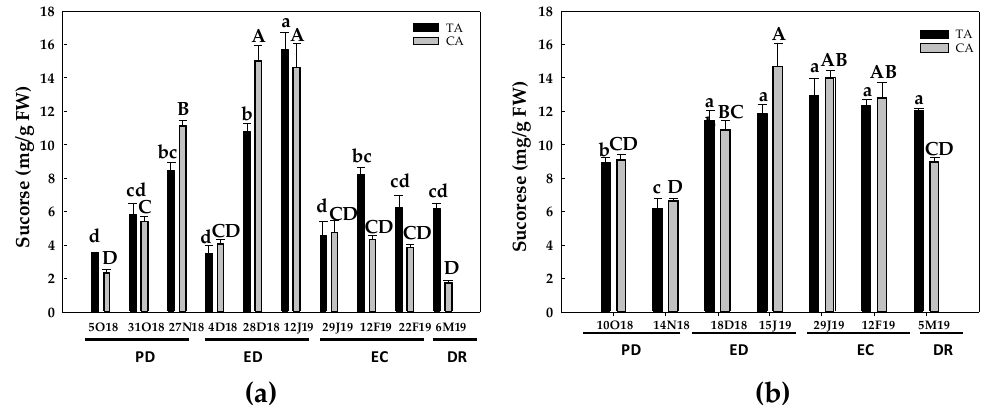
Figure 3. Evolution of sucrose contents in flower buds of peach ‘GEM020’ cultivated in two different geographical areas during the dormancy cycle on two seasons. ( a ): season 1 (2017–2018); ( b ): season 2 (2018–2019). Data represent the mean ± SE, n = 5. Different letters (lowercase and uppercase for the samples of the temperate (TA) and the cold area (CA), respectively) indicate significant differences according to Tukey’s multiple test ( p ≤ 0.05). PD: paradormancy; ED: endodormancy; EC: ecodormancy; DR: dormancy release. FW: fresh weight. The chill units accumulated at the different times and locations are shown in Supplemental file 1.